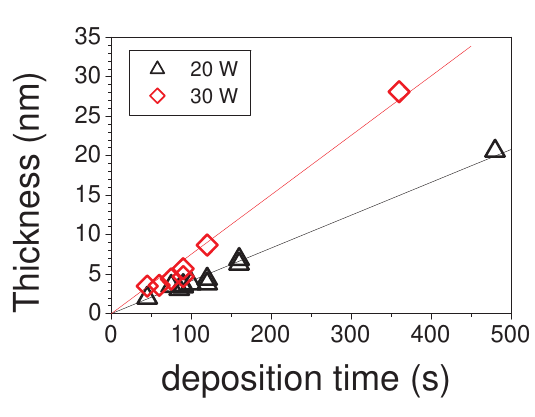
Figure 5. Collision frequency versus sample thickness. The value for bulk gold obtained from the simulation is also indi- cated. The continuous line represents the condition of mean free path equal to half the film thickness. The dashed line is a guide for the